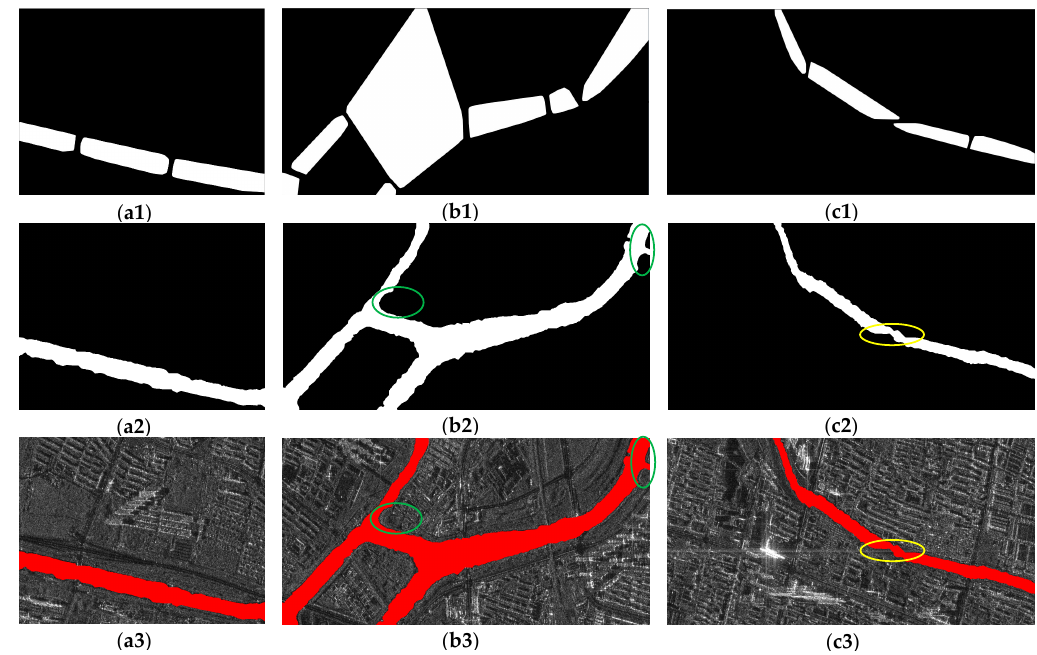
Figure 7. Results and evaluation. ( a1 )–( c1 ) Constructed convex hull. ( a2 )–( c2 ) Riverway extraction results. ( a3 )–( c3 ) Qualitative evaluation.